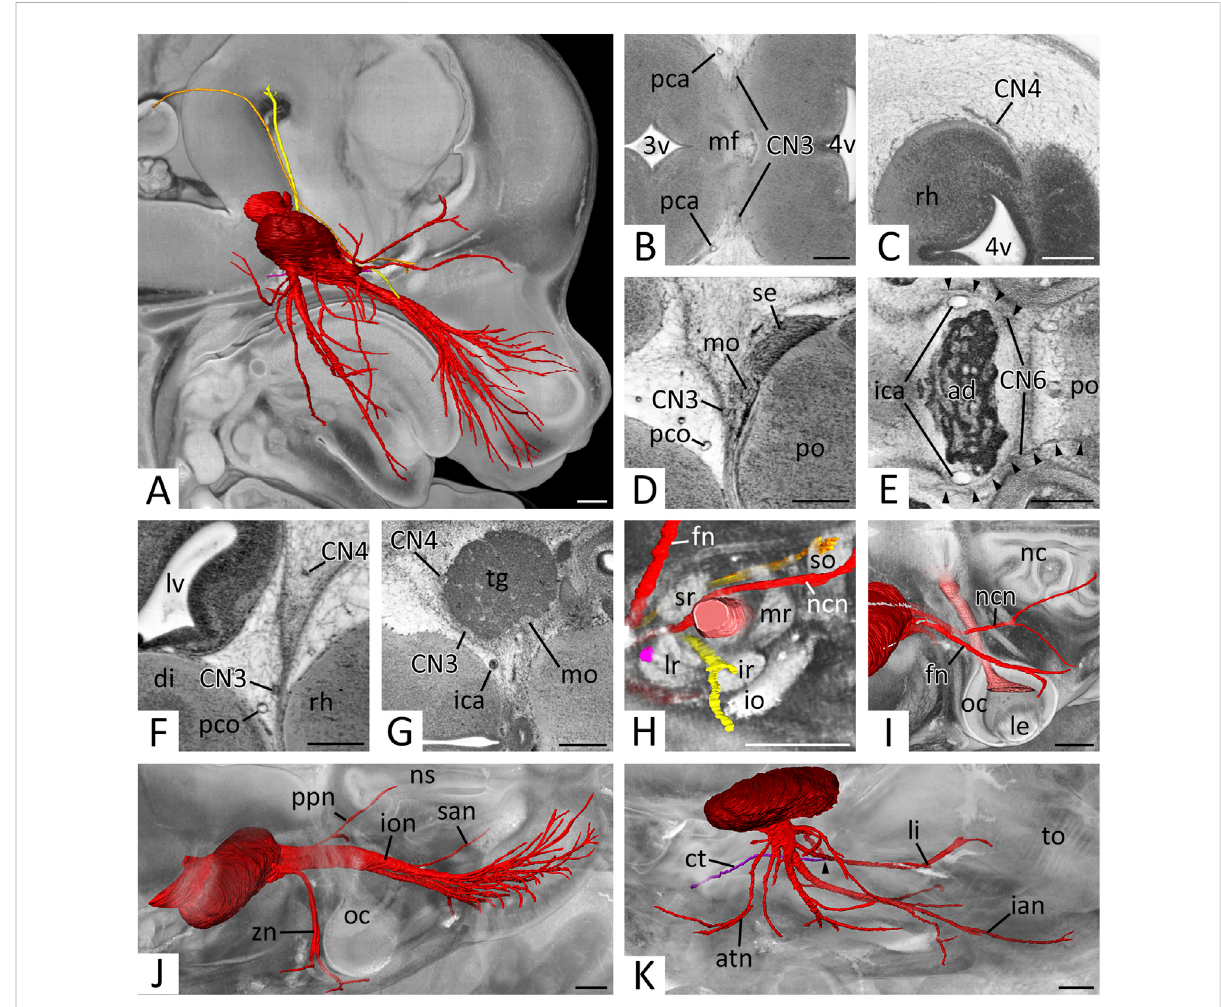
FIGURE 5 Cranialnerves(CN)3to6: (A) OverviewofrightCNs3,4,5and6.3Dsurfacerenderingsinthecontextofavolumerenderingofamouseembryo ofS23. View from right. CN3 (yellow), CN4 (orange), CN5 (red), trigeminal ganglion (dark red), CN6 (pink) (B – E) Exit ofCN3 (B) ,CN4 (C) , CN5 (D) and CN6 (E) in axial HREM sections. Anterior to the left, right on top. (B) Left and right CN3 emerging from the mesencephalic fl exure (mf) as multiple rootlets that then start forming a solid nerve. (C) Right CN4 emerging from, and circumventing the rhombencephalon (rh). (D) Right motoric (mo) and sensory (se) root of CN5 emerging from the pons (po). Note the close proximity to CN3. (E) Both CN6s (arrowheads) at the level of the adenohypophysis (ad). Notethe exit ofthe leftCN6 from thecaudal pons(po).Both CN6s run rostrally, lateral to theparasellar internal carotid artery (ica) (F) CaudalcourseofrightCN3andCN4lateraltothebrain.AxialHREMsection.Anteriortotheleft,rightontop (G) Righttrigeminalganglion(tg). Axial HREM sections. Anterior to the left, right on top. Note the adjacent CN3 and CN4 (H) Cranial nerves entering the right orbit. Surface renderings in the context of a volume rendering. View from lateral. CN2 (light red), CN3 (yellow), CN4 (orange), ophthalmic branches of CN5 (red), CN6 (pink). NoteCN3 and CN4 directly inside their innervatedmuscles (lr,so) (I – K) Branches ofthe righttrigeminalnerve. Surface renderings inthe context ofa volume rendering. View from cranio-lateral. (I) Ophthalmic branches (red) emerging from the trigeminal ganglion (dark red) and crossing CN2 (light red).Notethemarksontheganglion,whereCN3andCN4areadjacent(comparepanelG). (J) Maxillarybranches(red)emergingfromthetrigeminal ganglion (dark red). (K) Mandibular branches (red) emerging from the trigeminal ganglion (dark red). Note the connection of the chorda tympani (ct) (violet) with the lingual nerve (li) (arrowhead). Abr. 3v = third ventricle, 4v = fourth ventricle, atn = auriculotemporal nerve, di = diencephalon, fn = frontal nerve, ian = inferior alveolar nerve, io = inferior oblique muscle, ion = infraorbital nerve, ir = inferior rectus muscle, le = lens, lr = lateral rectus muscle,lv=lateralventricle, mr=medial rectusmuscle,nc=nasalcavity,ncn=nasociliarynerve,ns=nasalseptum,oc=opticcup,pca=posterior cerebralartery,pco=posteriorcommunicatingartery,ppn=pterygopalatinenerve,san=superioralveolarnerve,so=superiorobliquemuscle,sr= superior rectus muscle, to = tongue, zn = zygomatic nerve. Scale bars = 250